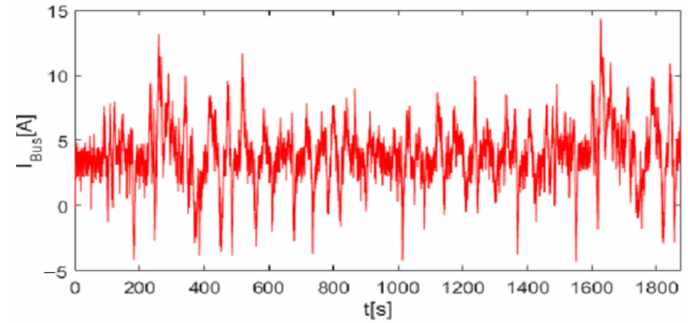
Figure 26. Bidirectional load